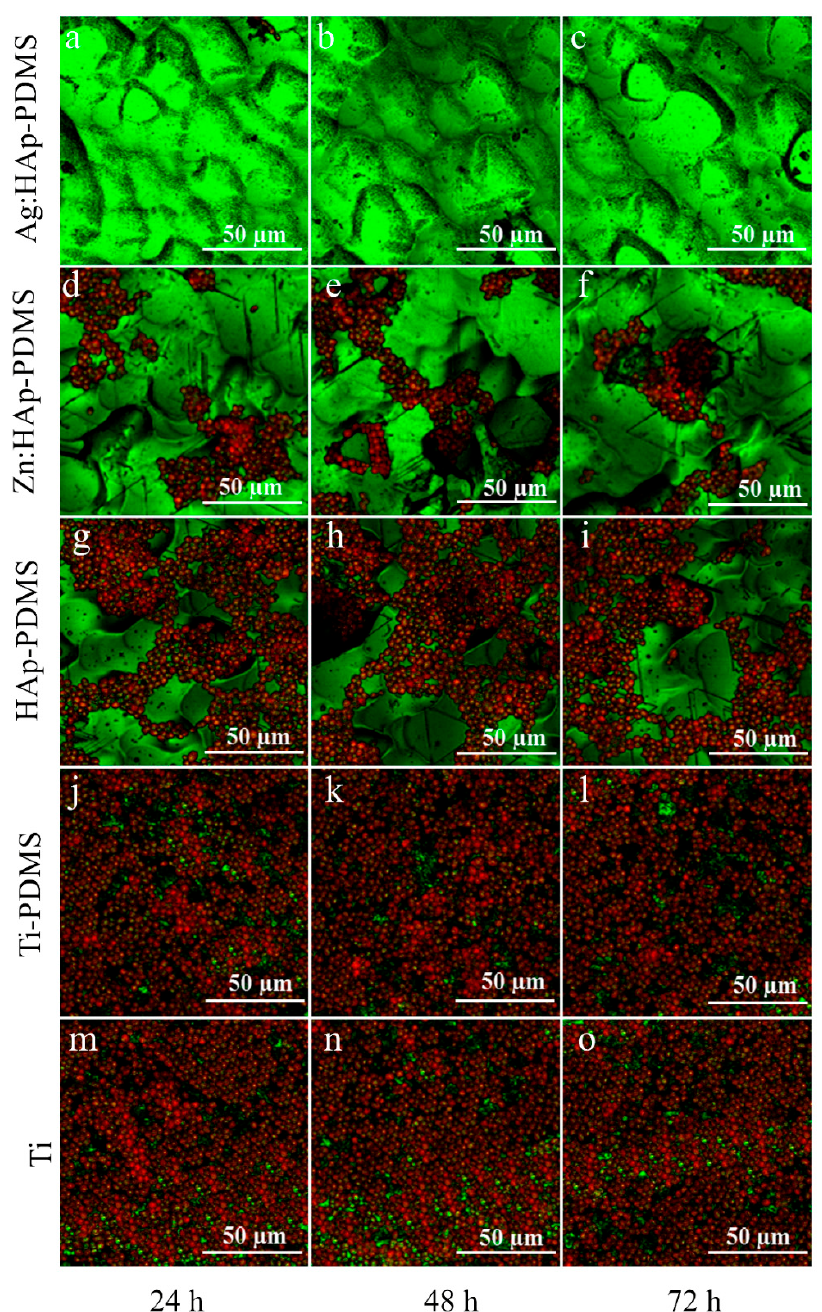
Figure 9. CLSM of biofilm image of C. albicans biofilm stained with propidium iodide developed on